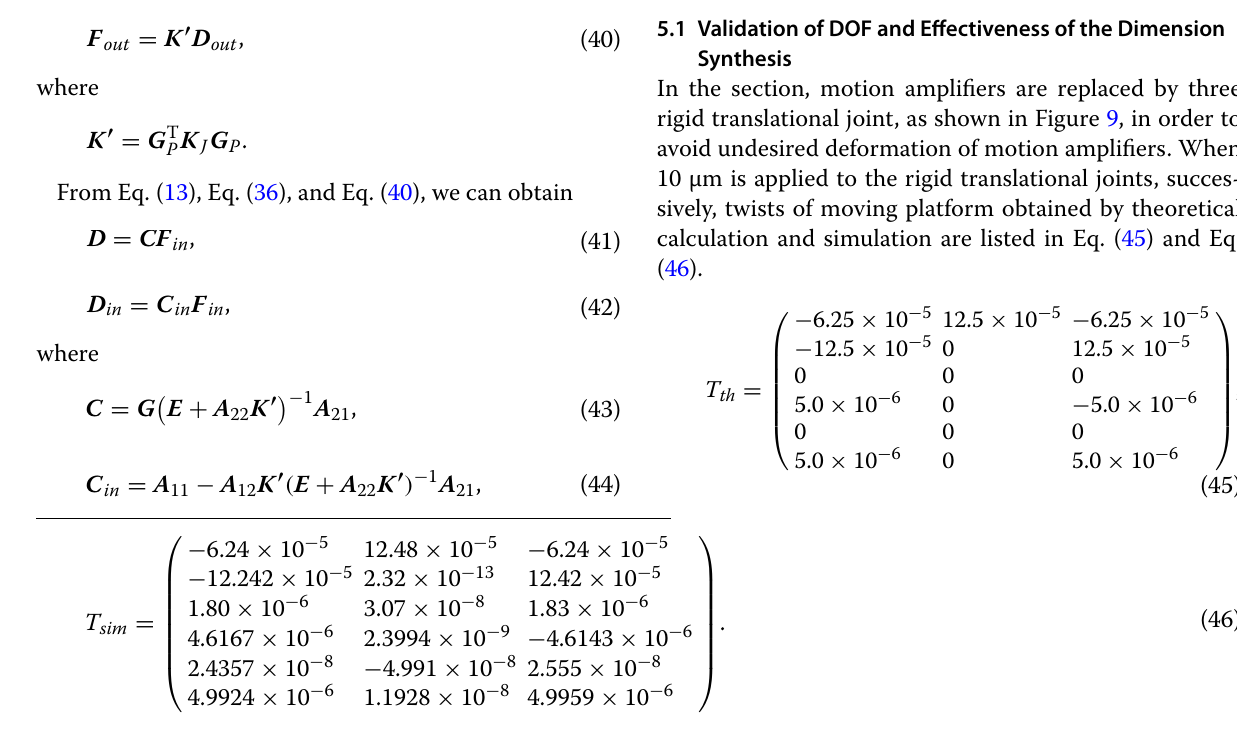
C is the compliant matrix of the whole mechanism. C in is input compliant matrix of the whole